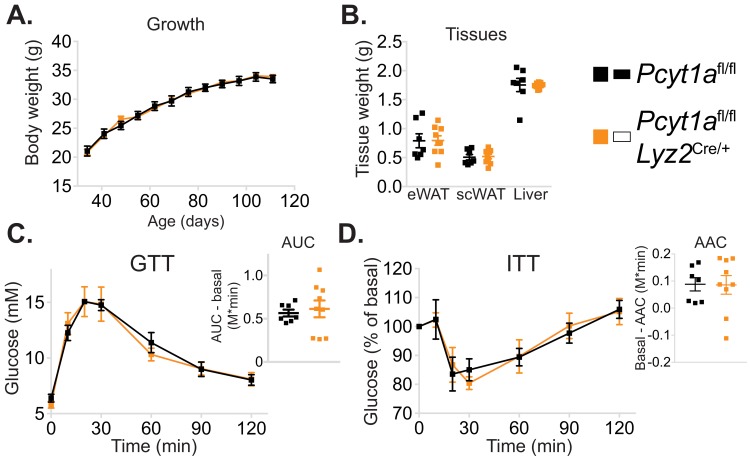
Myeloid cell-specific deletion of Pcyt1a does not affect growth or glucose metabolism of lean mice.(A) Body weight gain curves and (B) tissue weights of lean mice. (C) GTT curves and areas under curve (AUC), normalised to basal glucose levels. (D) ITT curves, presented as percentage values of basal glucose levels, and areas above curve (AAC), normalised to basal glucose levels.